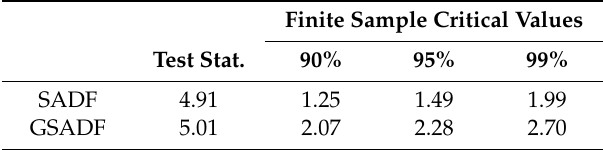
Table 4. The SADF TEST and the GSADF TEST of the West Texas Intermediate (WTI) Price. Finite Sample Critical Values